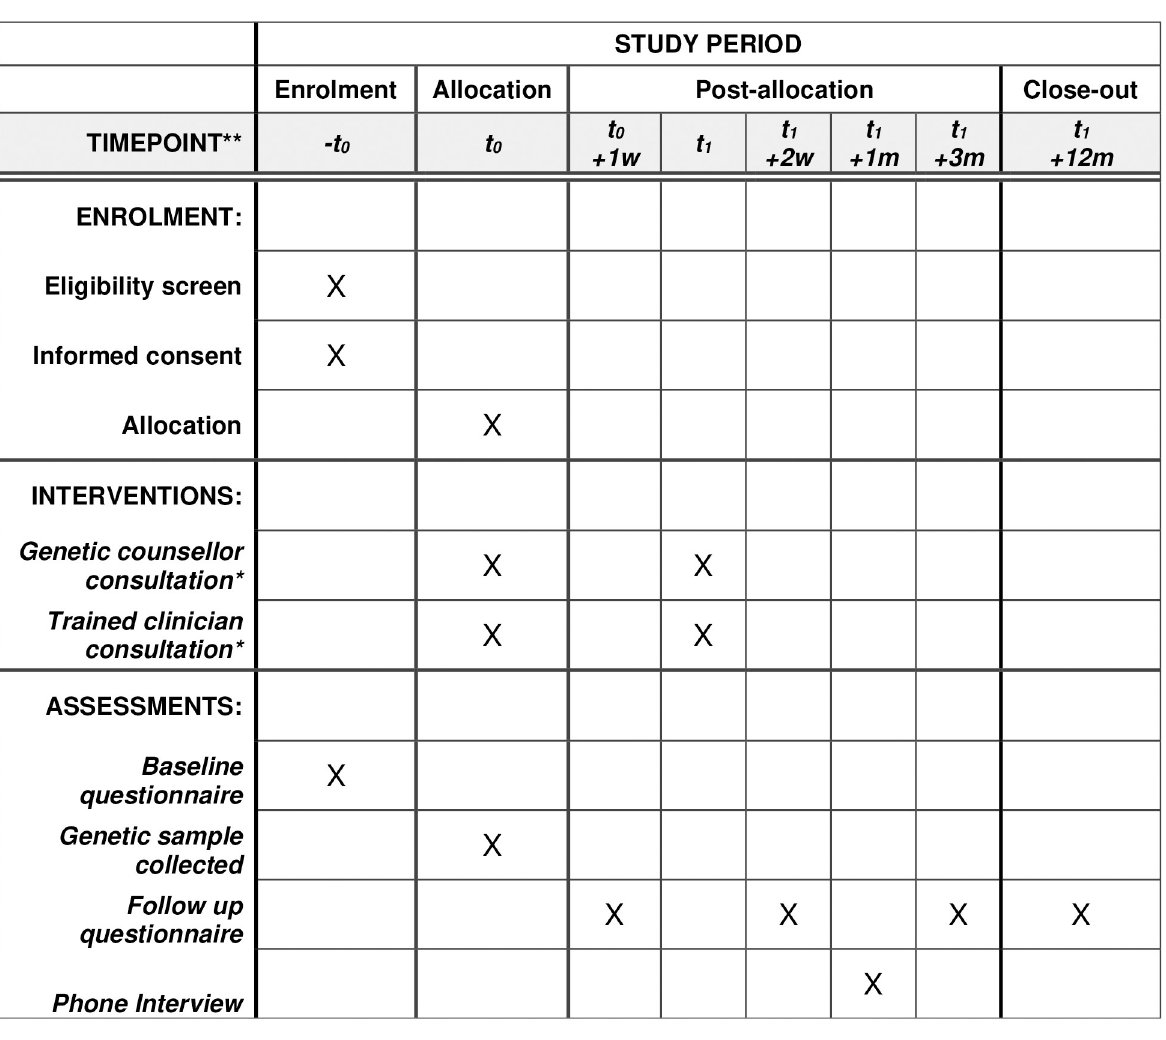
Fig 1. Standard protocol time points and items based on the SPIRIT schedule of enrolment, interventions, and